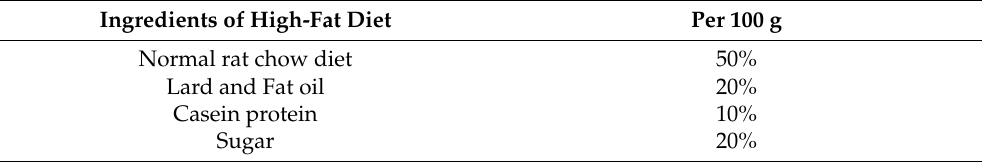
Table 1. Ingredients (%/100 g) of commercial feed.